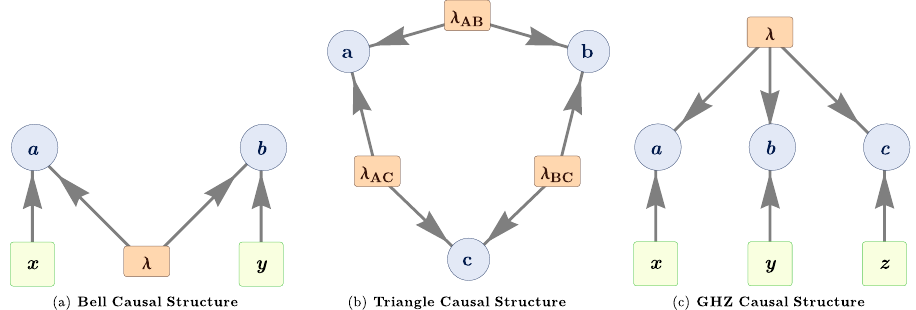
Fig.1|Directedacyclicgraph(DAG)representationofdifferentclassicalcausal scenarios.a TheBellscenarioisacausalstructureinwhichasource λ correlatesthe two parties having measurement outcomes a and b and choices x and y , respec- tively. b The triangle scenario involvesthreeindependentsources λ AB , λ BC ,and λ AC , which establish correlations between pairwise stations A , B , and C . Note that